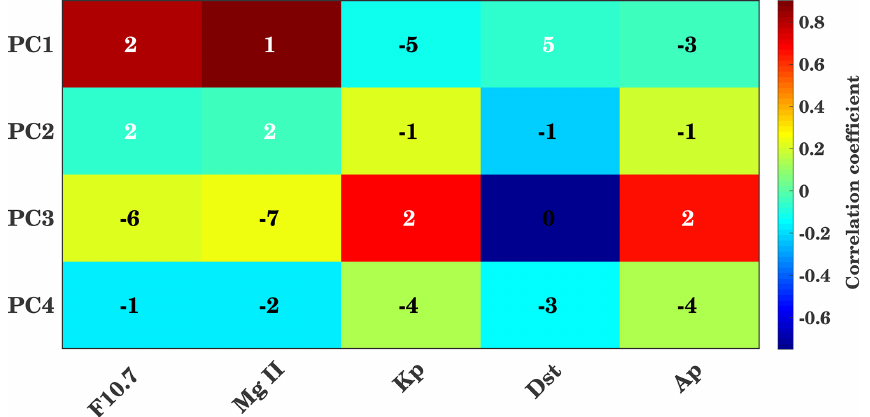
Figure 12. Correlation coefficients and time lag between the PCs and solar and geomagnetic proxies. Background colors show the maximum correlation coefficients, and the inserted numbers show the delay in days corresponding to maximum correlation.